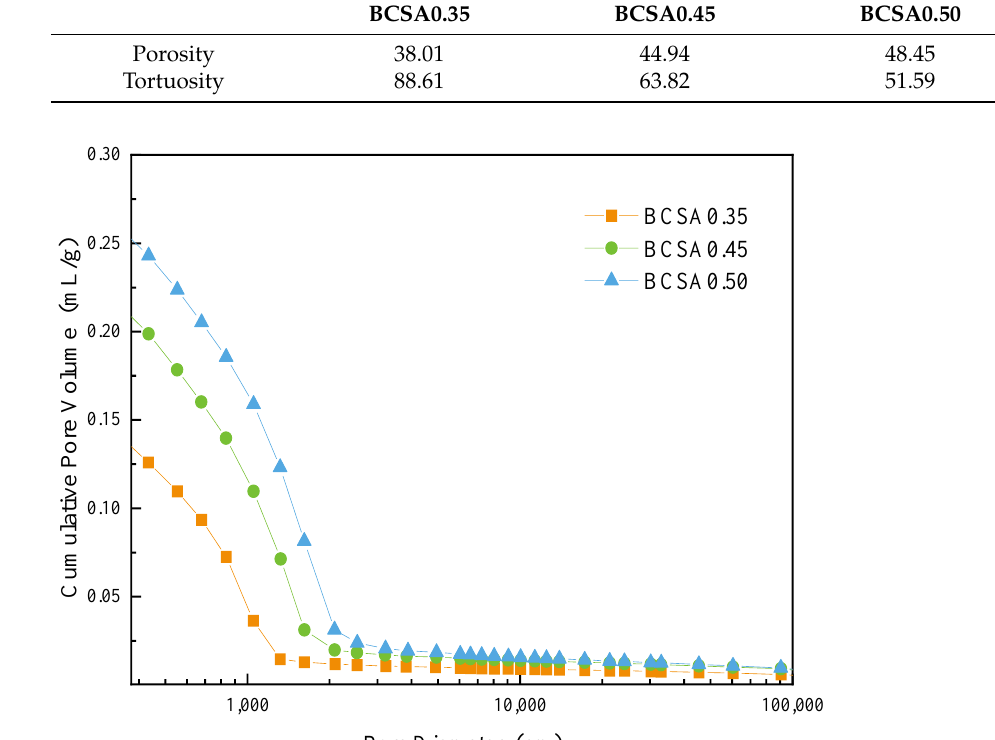
Table 2. Porosity and tortuosity of BCSA cement pastes.